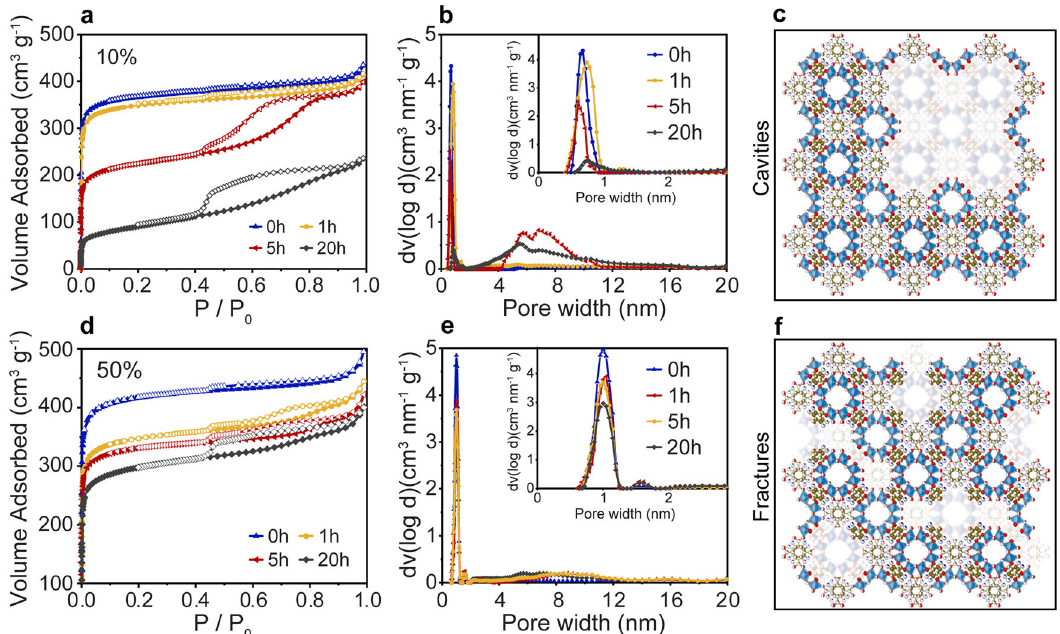
Fig. 6 Characterization of added mesopores. a , d Ar physisorption isotherms at 87 K for 10% and 50%NH 2 -MIL respectively, for as-prepared samples and those heated at 300 °C for 1, 5 and 20 h. b , e The corresponding NLDFT pore size distributions (adsorption branch) for 10% and 50%NH 2 -MIL. c , f Schematic representations of the mesopores re fl ecting cavity-type pore structures and fracture-type pores,